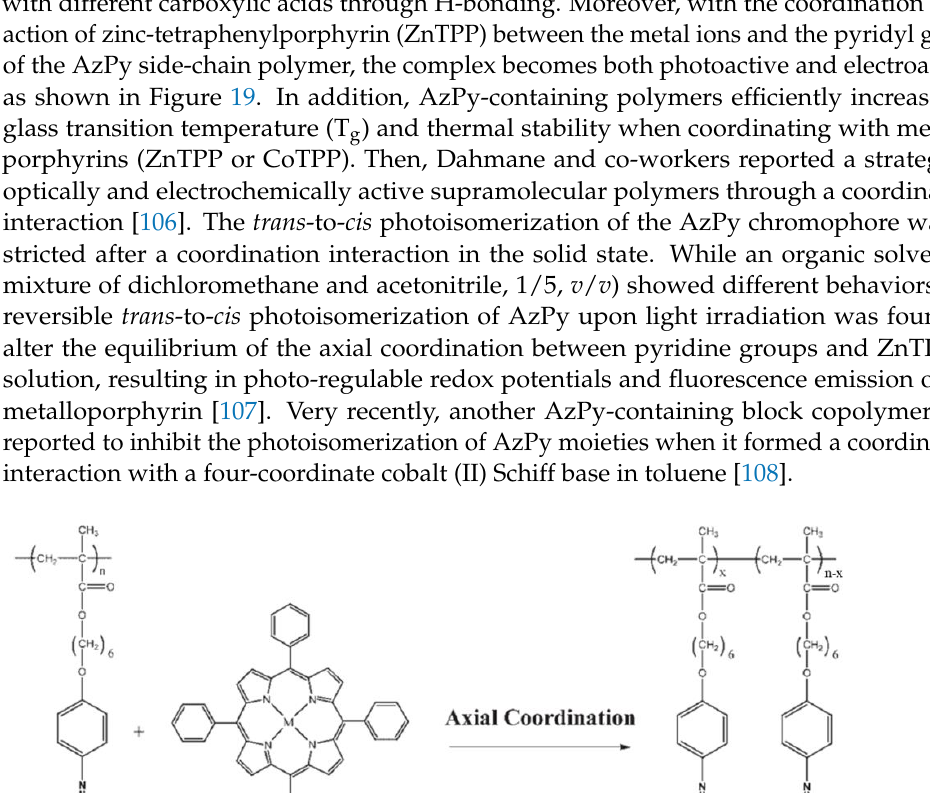
Figure 20. ( a ) Chemical structure and photoinduced dimensional transition of the PAzPCC self- assembly, insets SEM images of assemblies upon the irradiation of 365 nm light for different times. ( b ) The coordination interaction of AzPy gelator with Ni 2+ , Eu 3+ , Cu 2+ , and Bi 3+ produce helical chi- rality nanofibers. Reprinted with permission from [109]. Copyright 2018, American Chemical Soci- ety.